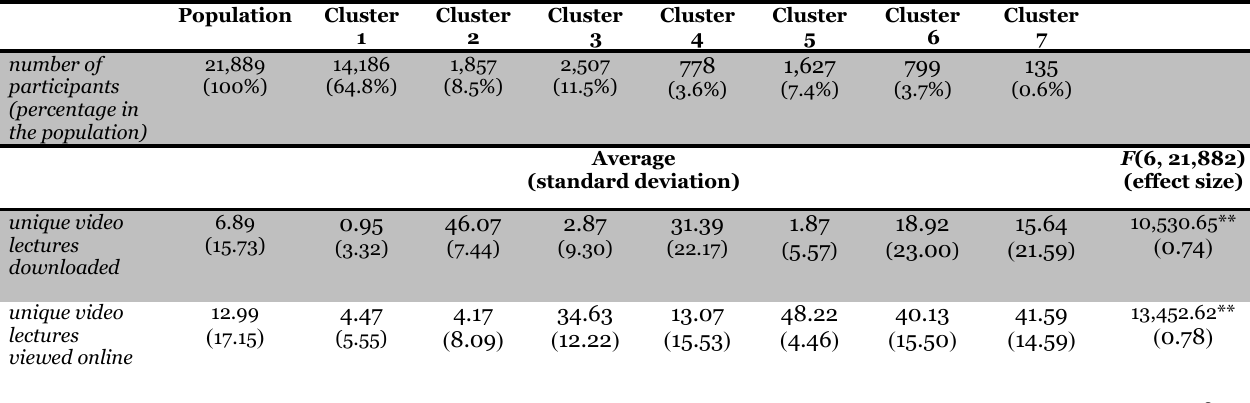
The Clusters Obtained From the Cluster Analysis